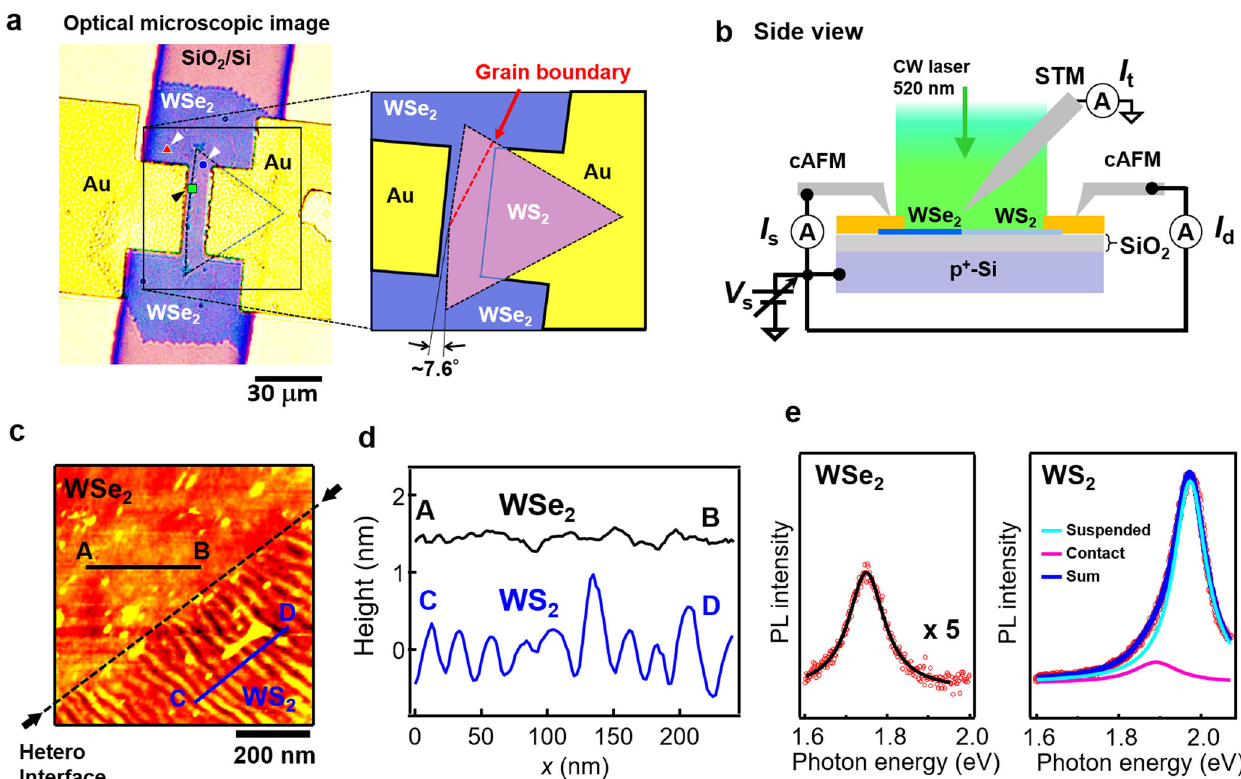
Fig. 2 Single-layer WS 2 /WSe 2 in-plane heterostructure sample prepared on a Si/SiO 2 substrate. a Optical microscope image of the sample setup, and a schematic illustration of the sample showing the structure of the area surrounded by the square frame in the optical image. After growing a threefold-symmetric WS 2 structure, a WSe 2 structure is grown around it 18 . In the schematic illustration, the Au electrode on WS 2 is transparent. The pale-yellow areas above and below the Au electrodes are Au thin fi lms of different thicknesses. The left and right sides of the SiO 2 /Si regions are shadows due to the Au thin fi lms on the outside. b Schematic of the measurement setup. c , STM topography image acquired at the WSe 2 /WS 2 heterointerface, which position is shown in a with a green square. d Line pro fi les along AB and CD in c. The ripple structure is clearly shown in the WS 2 area. e Fluorescence spectrum measured in each region of WSe 2 and WS 2 (excitation wavelength 532 nm, spot diameter 2 μ m, excitation power 2.5 mW). Measured positions are marked in a with a red (WSe 2 ) and a blue (WS 2 ) circles, respectively. The spectrum for WS 2 (blue curve) can be divided into two peaks (pink and light blue curves) with different intensity by fi